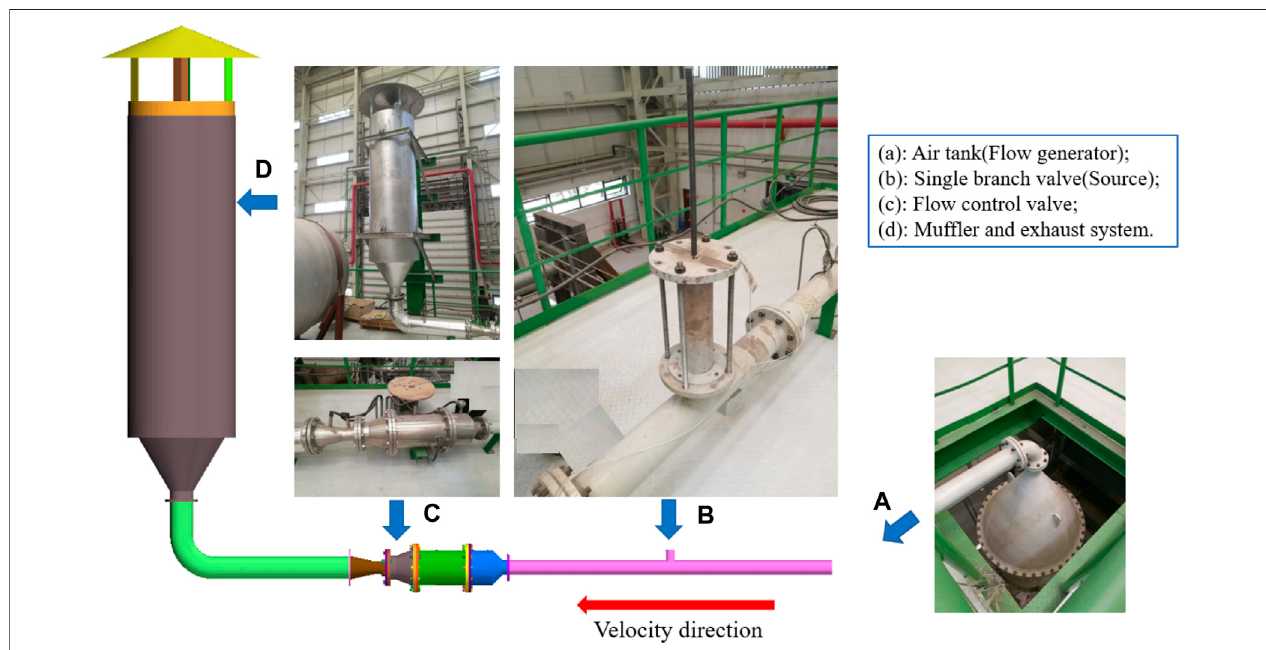
FIGURE 6 | Aero-Acoustics source generation system.